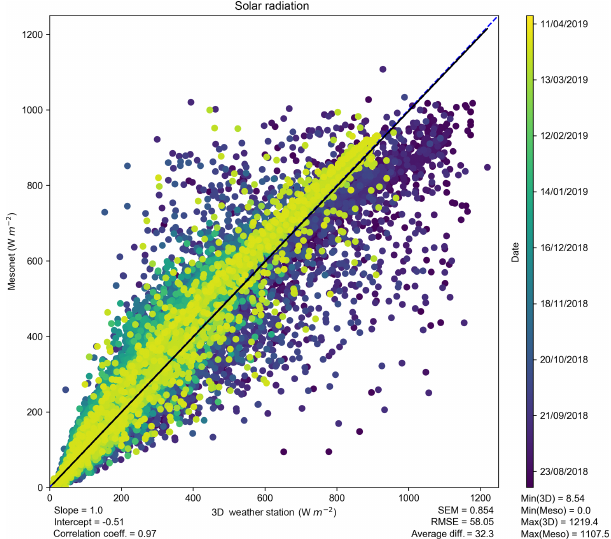
Figure 11. Comparison of the low-cost SI1145 UV sensor ( x ) and the Oklahoma Mesonet downwelling global solar radiation ( y ) for the entire deployment, color-coded by time. The one-to-one refer- ence line (blue dashed) and linear regression line (black solid) are overlaid.